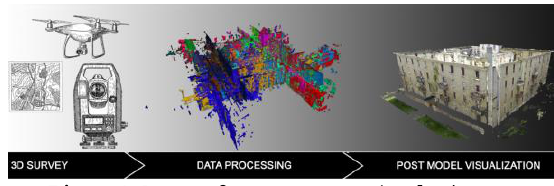
Figure 4: Process from survey to point cloud.